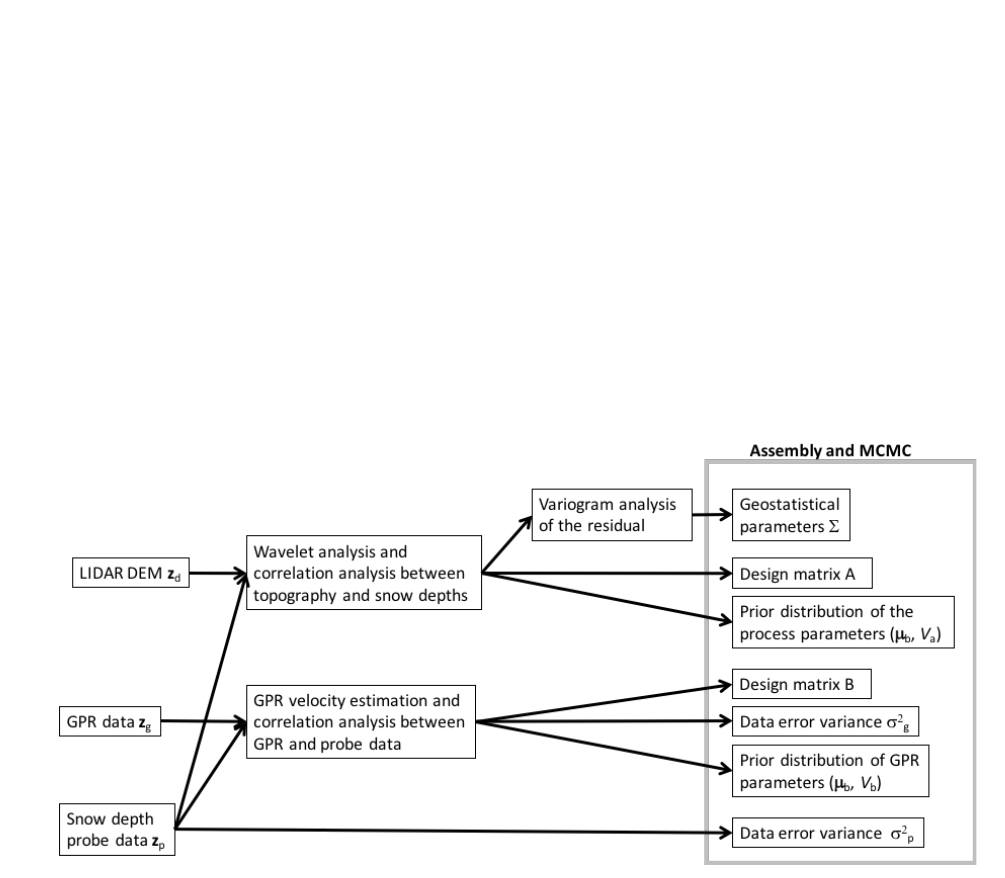
Figure B1. Workflow of the Bayesian geostatistical